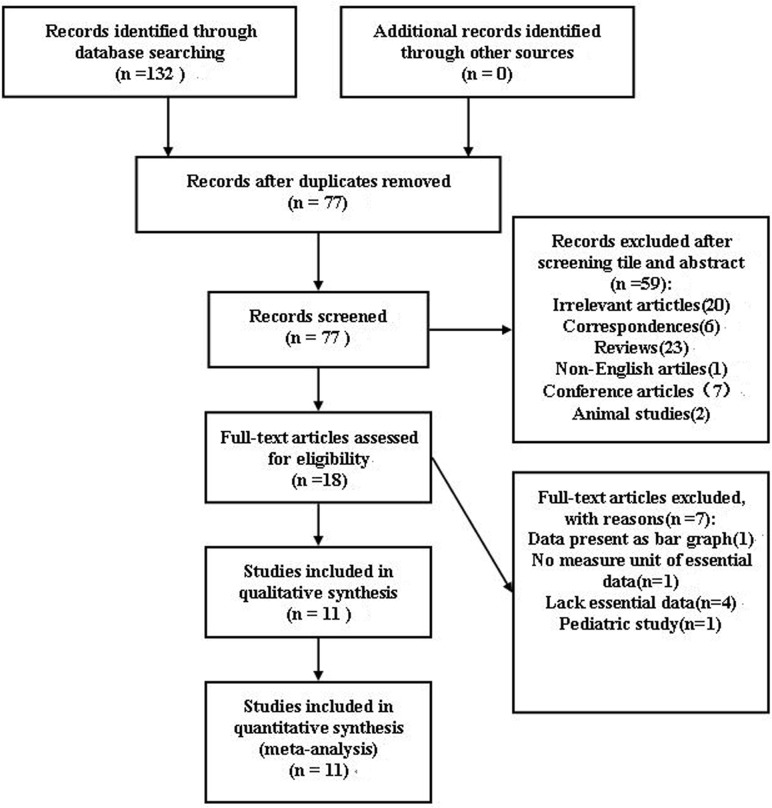
Flow diagram of study selection.